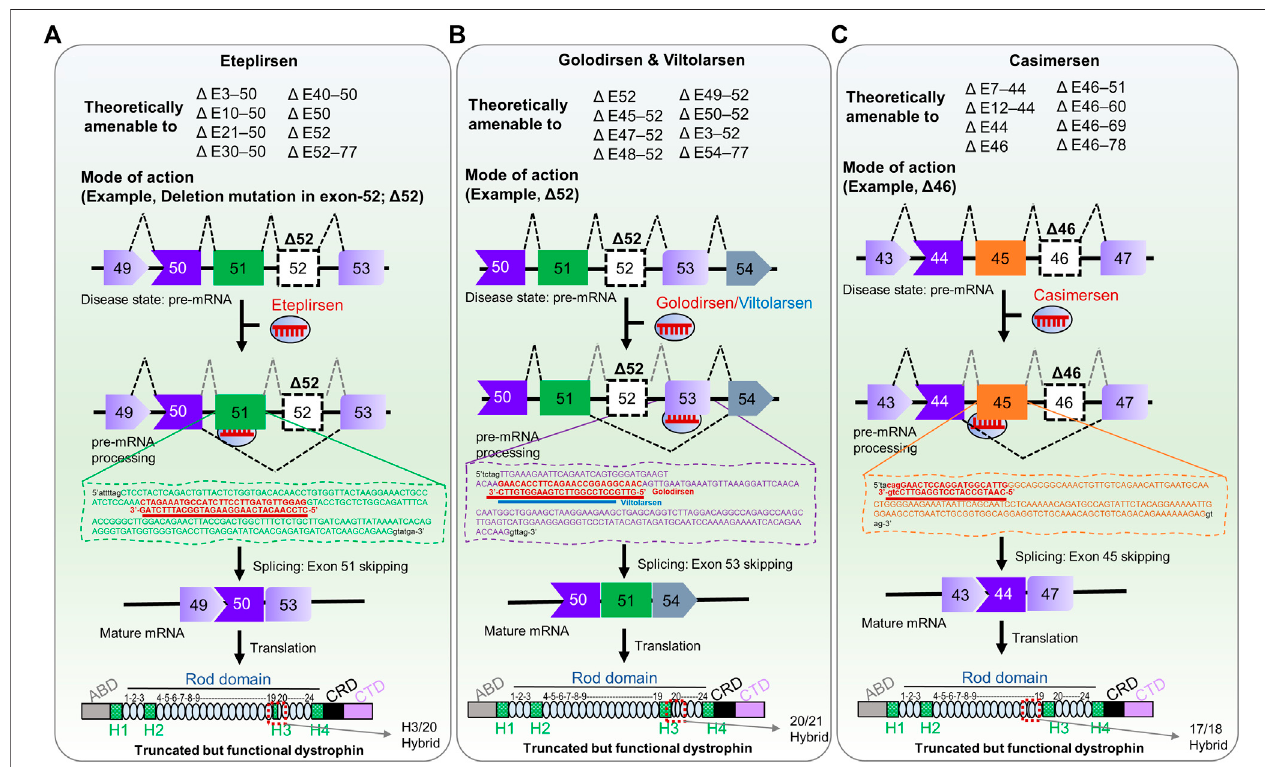
FIGURE1| FDA-approvedRNAtherapiesforpatients withcon fi rmed,speci fi c DMD mutations. (A) Eteplirsen,amorpholino ASOthatpromotesexon51-skipping inpatientswithDMD. (B) Golodirsen&Viltolarsen,morpholinoASOsthatcausesexon53-skippinginDMDpatients. (C) Casimersen,isamorpholinooligonucleotidethat skips exon 45 in patients with DMD. The potential deletion mutations that could be responsive to each therapy are shown in upper panels (Aartsma-Rus et al., 2009; Fletcher et al., 2010); Δ , deletion mutation; E, exon; the number indicates exon number of DMD gene. The mechanism of action of each therapy is shown in the lower panelasanexample ofdeletion mutationexon 52( Δ 52) anddeletion mutationexon46( Δ 46). Theultimate fateofexonskippingindystrophinstructure isshown in each panel; ABD, Actin bindingdomain; H1-H4, Hingedomains; Roddomain contains 24domains; CRD, Cysteine-richdomain; CTD,C-terminaldomain. Theexon51/ 52 skipping, exon 52/53 skipping, and 45/46 skipping resulted in the H3-Rod20 hybrid (H3/20 as indicated), Rod 20/21 hybrid, and Rod 17/18 hybrid dystrophin,